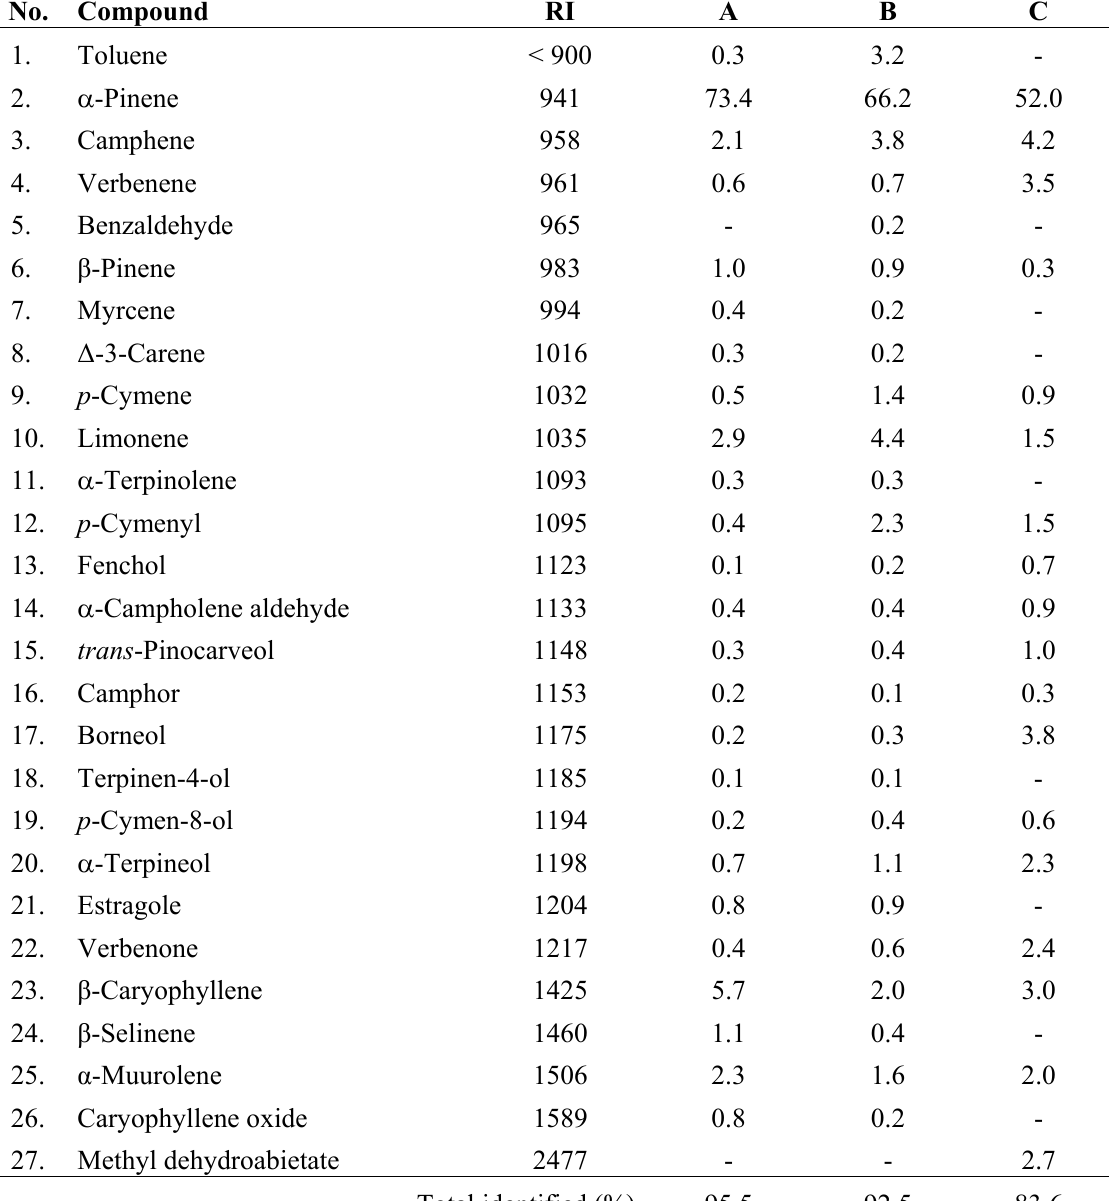
Table 2. The pine resin VOCs composition obtained by HS-SPME and from the resin CH Cl solution after direct GC and GC-MS 2 2